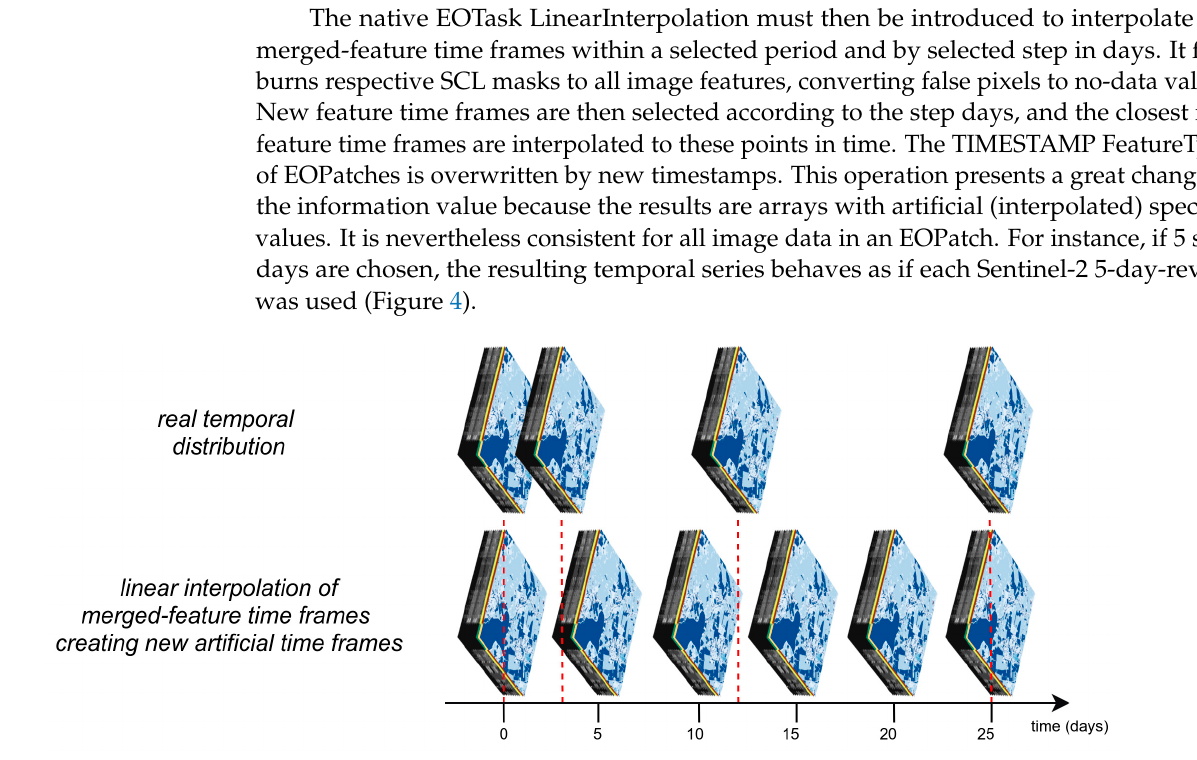
Figure 4. Linear interpolation of merged-feature time frames with five step days chosen.